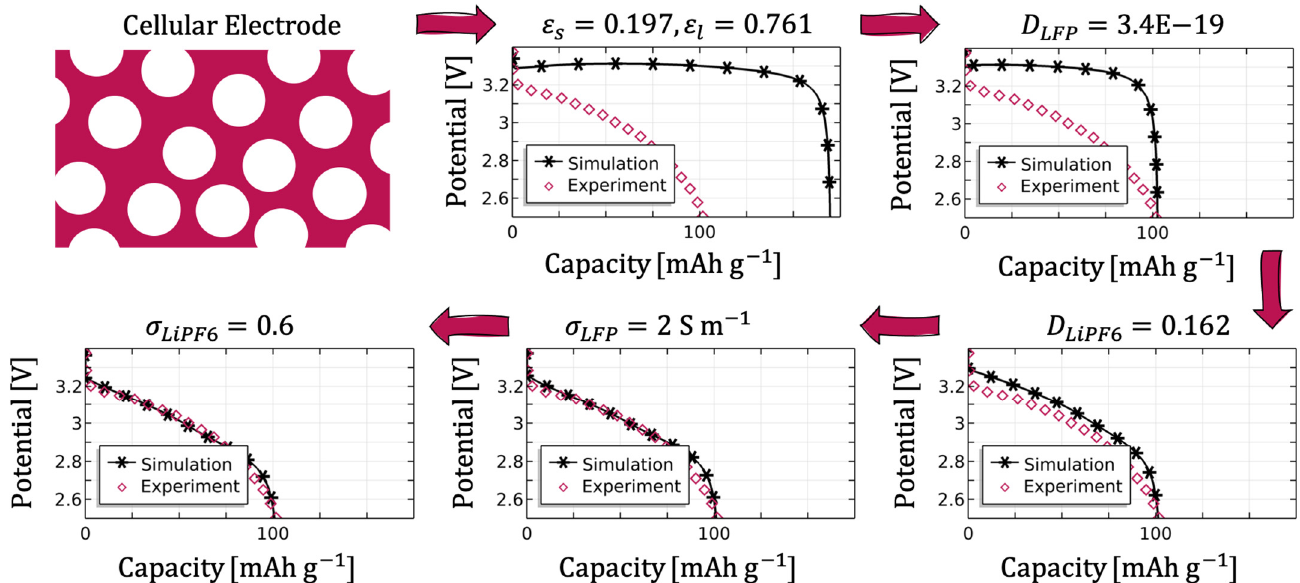
Figure 18. Determination of the model parameters using the proposed procedure for simulating the cellular structure.